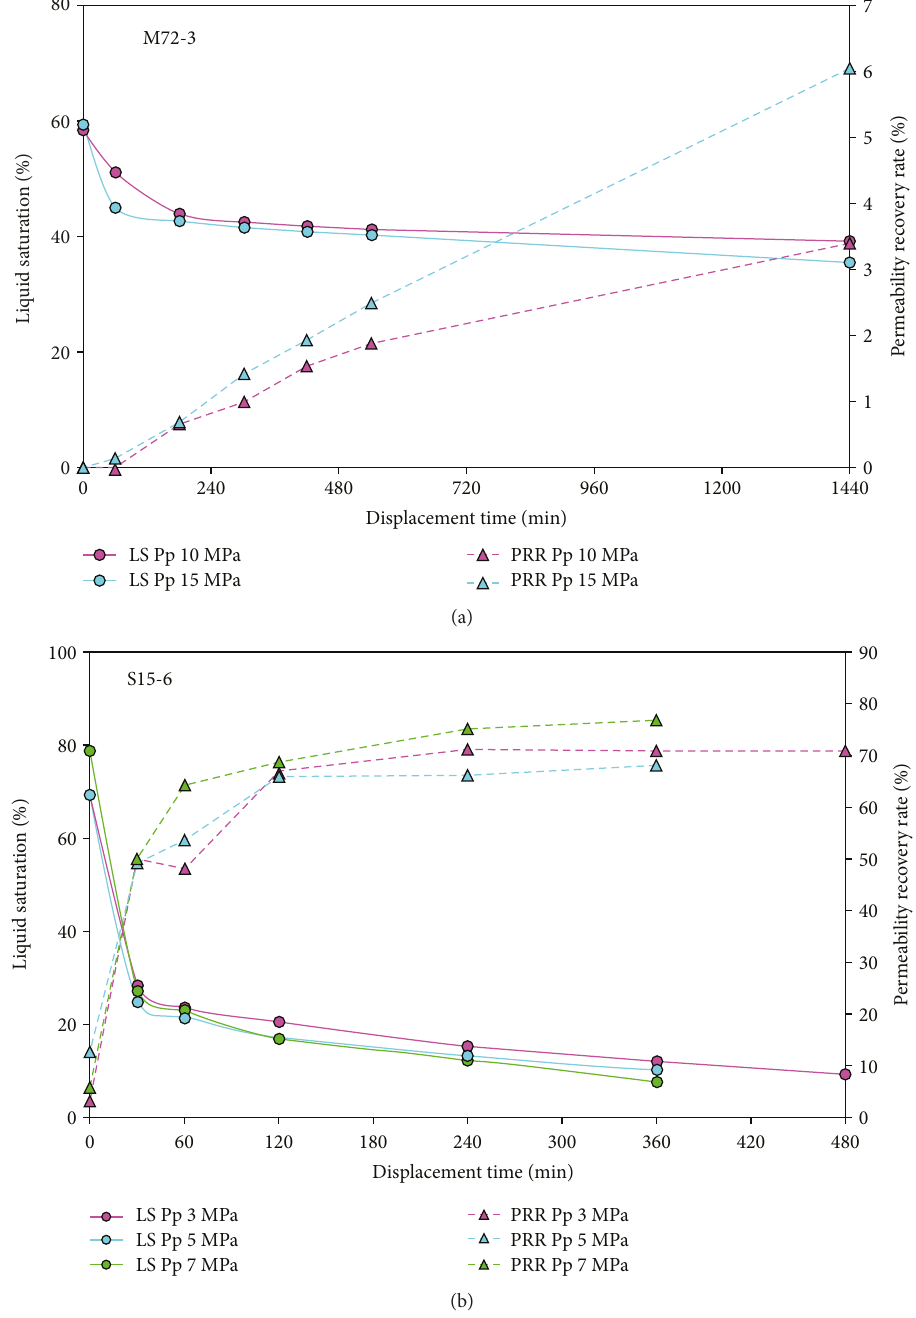
Figure 15: The variation of liquid saturation and permeability recovery rate with displacement time in H8 formation. Con fi ning pressure is